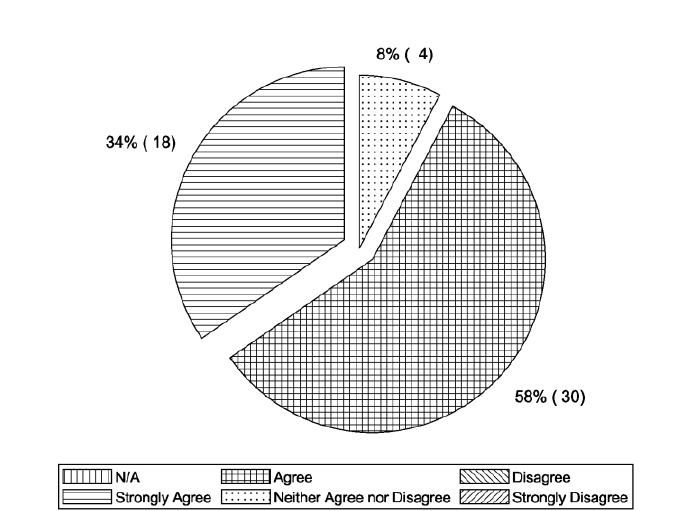
Fig. 7. Understanding Engineering and Engineers after taking this course.